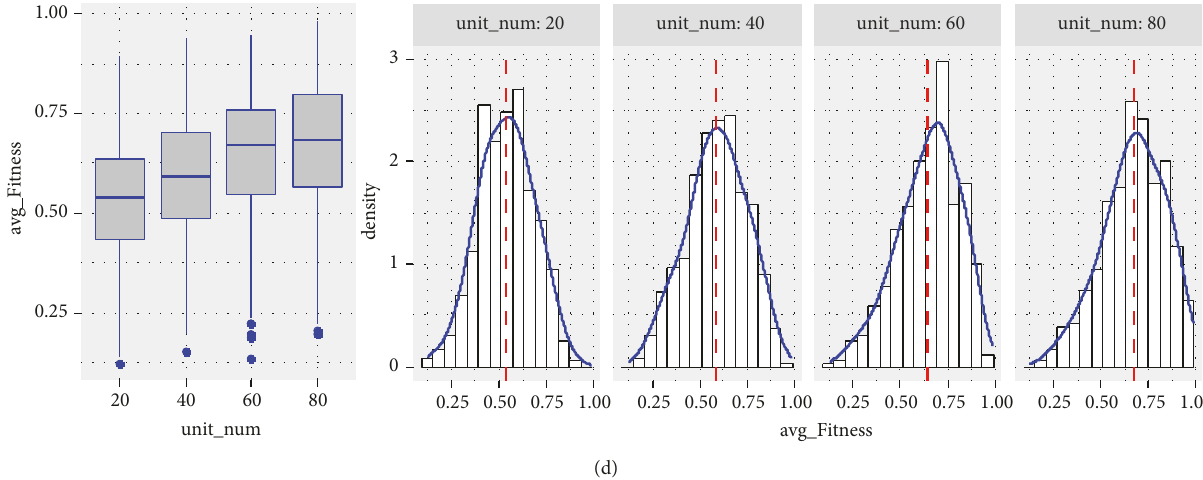
Figure 5: Simulation outputs of the testing scenario: (a) a sketch of the three output variables; (b) distribution of steadyTime ; (c) distribution of replicate num ; (d) distribution of avg